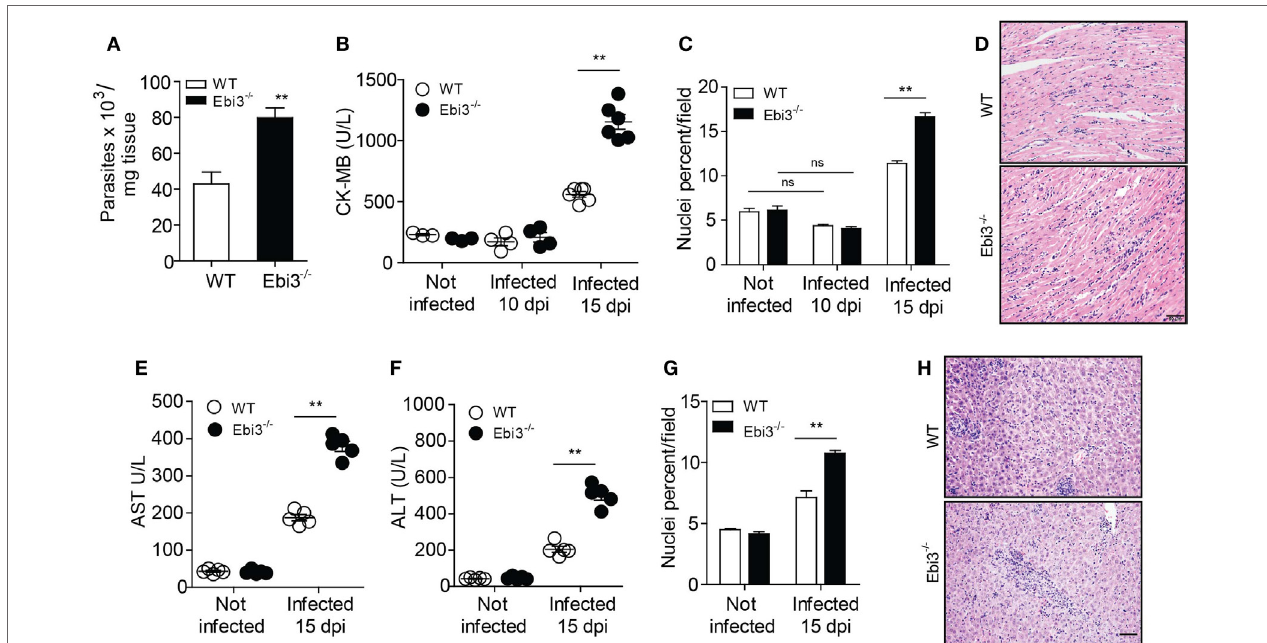
FigUre 3 | IL-27 is required to prevent cardiac parasitism and tissue damage after infection. (a) Parasitism in heart tissue of wild-type (WT) and Ebi3-deficient mice was assessed by qPCR and quantified by using a standard curve prepared with parasite DNA extracted from 1 × 10 7 cultured Trypanosoma cruzi . qPCR was performed 15 d.p.i. with T. cruzi . (B) Heart damage was quantified by measuring CK-MB released into the blood. (c,D) Hematoxylin and eosin (H&E) staining of heart samples from infected wild-type (WT) and Ebi3-deficient mice. The images were taken and the inflammatory infiltrate was quantified using the Image J program at 200 × magnification. Scale bar = 50 µm. (e,F) Serum AST and ALT levels were measured in WT and EBi3-deficient mice 15 days after infection. The enzymes were evaluated using commercial kits and the individual results expressed in U/L. (g,h) H&E staining of liver samples from infected WT and EBi3-deficient mice. The inflammatory infiltrate was quantified with the Image J program at 200 × magnification. Scale bar = 50 µm. Data are expressed as mean ± SEM ( P < 0.05) and are representative of two independent experiments ( n =